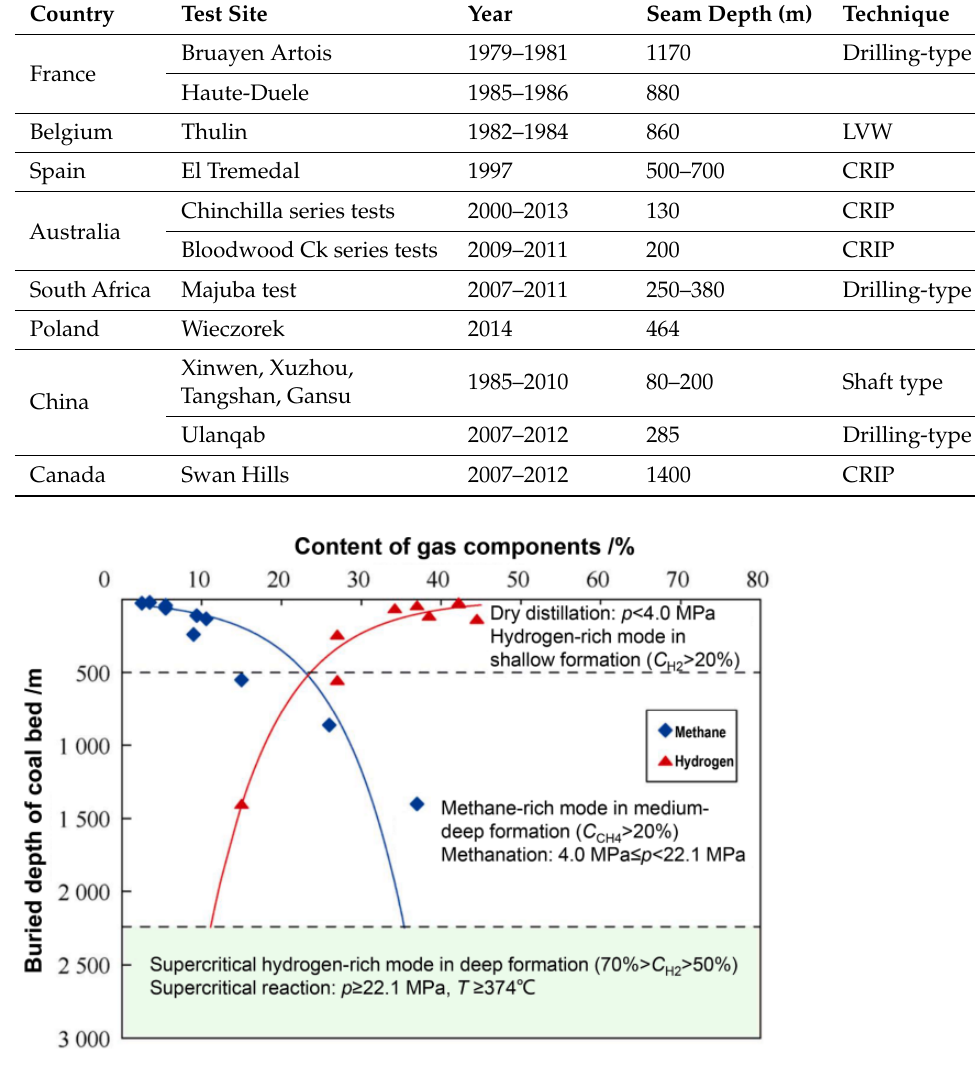
Figure 14. Three exploitation modes of UCG (from